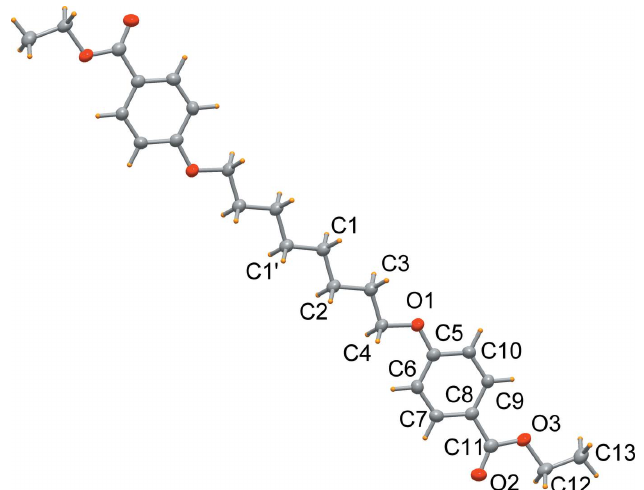
Figure 1 ORTEP view (ellipsoids drawn at the 50% probability level) of the title molecule. C1 0 and unlabelled atoms are generated by the symmetry operation (cid:5) x + 2, (cid:5) y + 2, (cid:5) z .